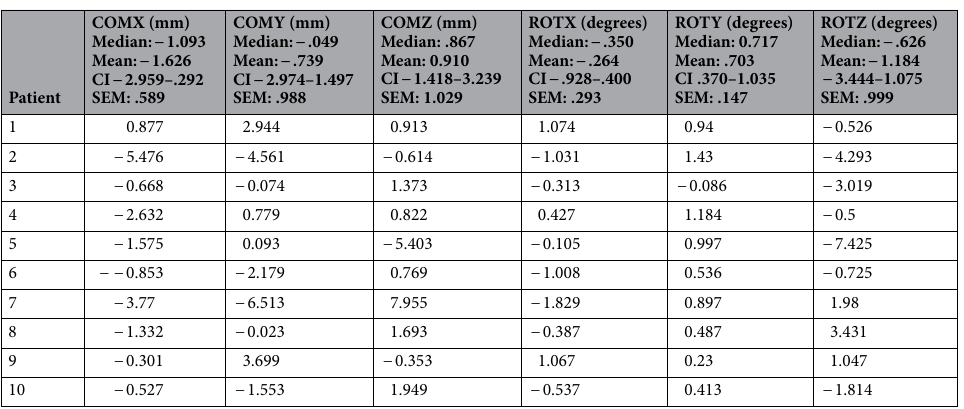
Table 1. Illustrates translation of COM (Centre of Mass) alongside X, Y and Z axes. Further illustrates rotational changes for all 10 patients, between proximal and distal parts of the merged 3D images of the right lower legs and mirrored images of the left lower legs. SEM; Standard error of the mean.